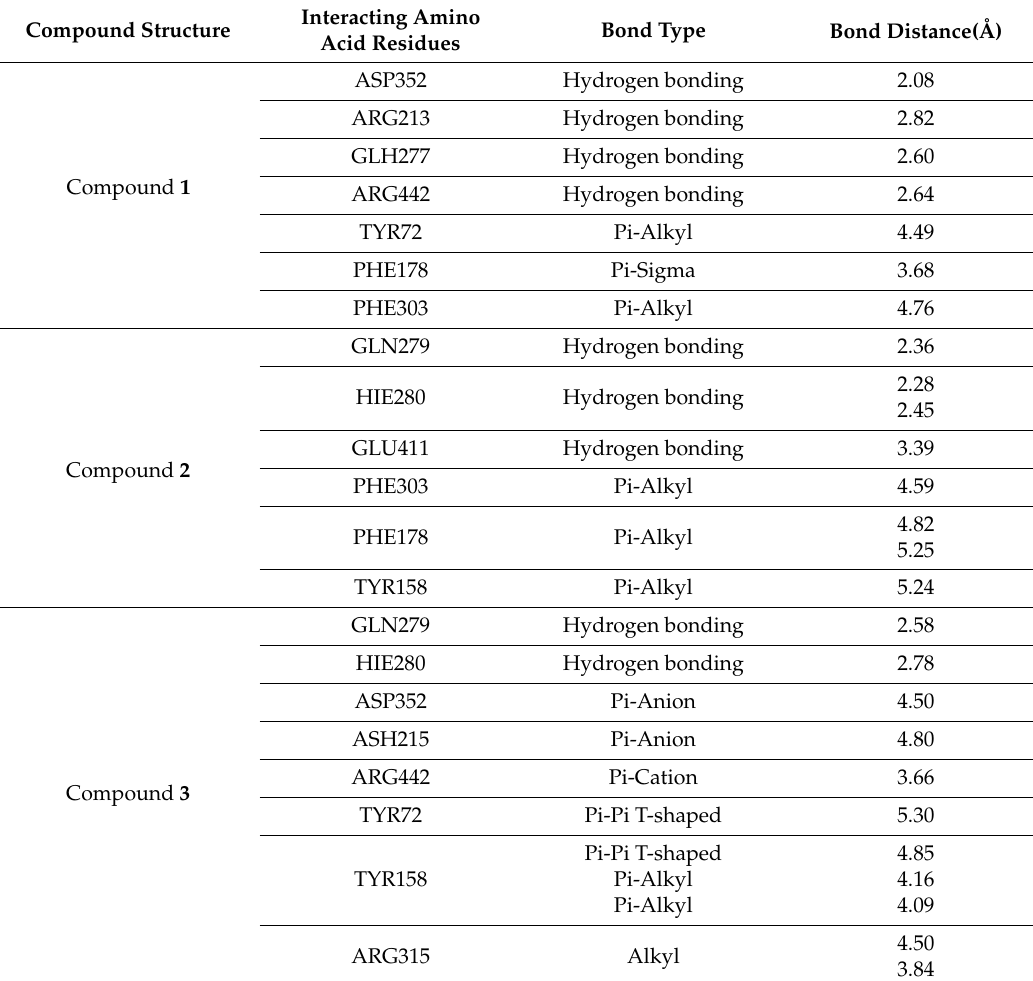
Table 3. Data for the molecular docking of compounds 1 , 2 , and 3 in